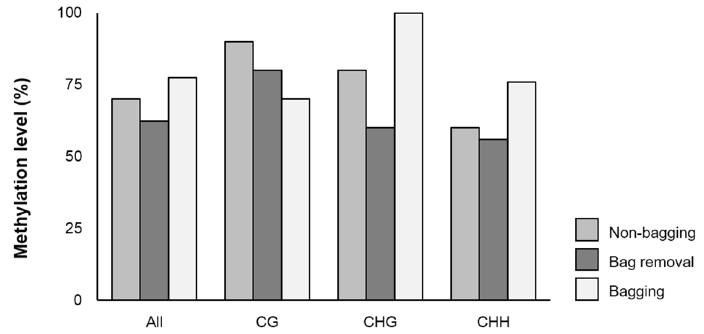
Figure 5. Cytosine methylation levels in the M7 region of MdMYB10 promoter in mature ‘Fuji’ ap- ples cultivated under different bag treatments: no bagging (control; labeled as “non-bagging”), bag- ging followed by bag removal (labeled as “bag removal”), and bagging with no bag removal (la- beled as “bagging”). The x -axis and y -axis indicate different cytosine contexts (CG, CHG, and CHH) and methylation level, respectively. For each bag treatment, ten clones were detected by bisulfite while H indicates A, C, or T.